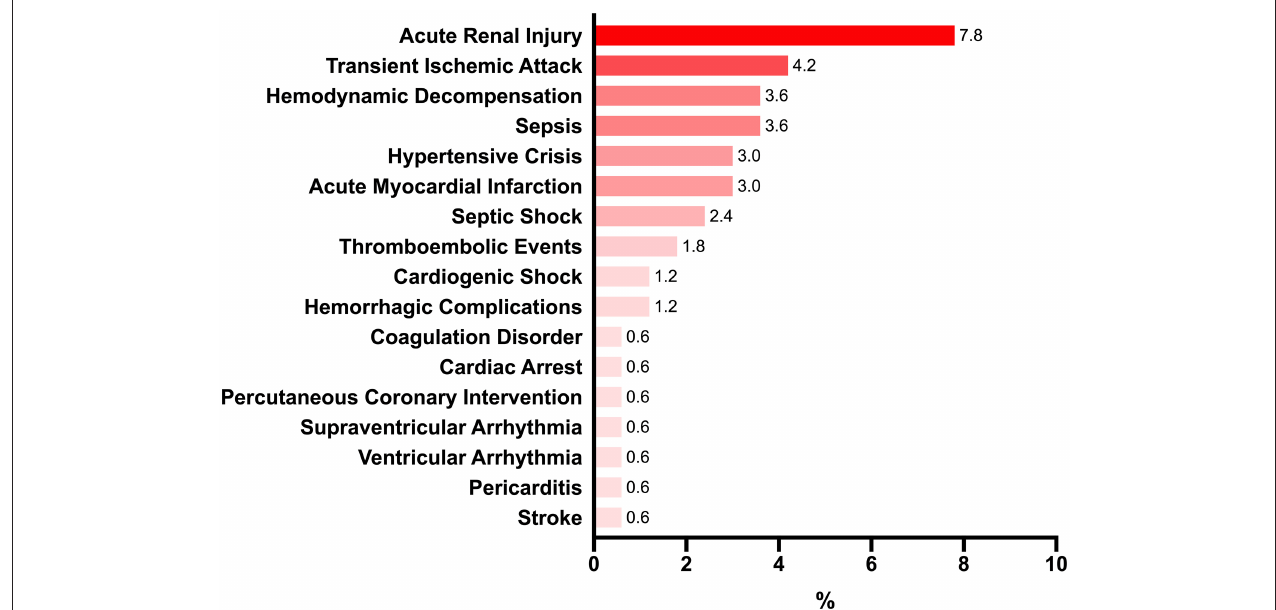
FIGURE 1 | Main complications occurring during hospitalization